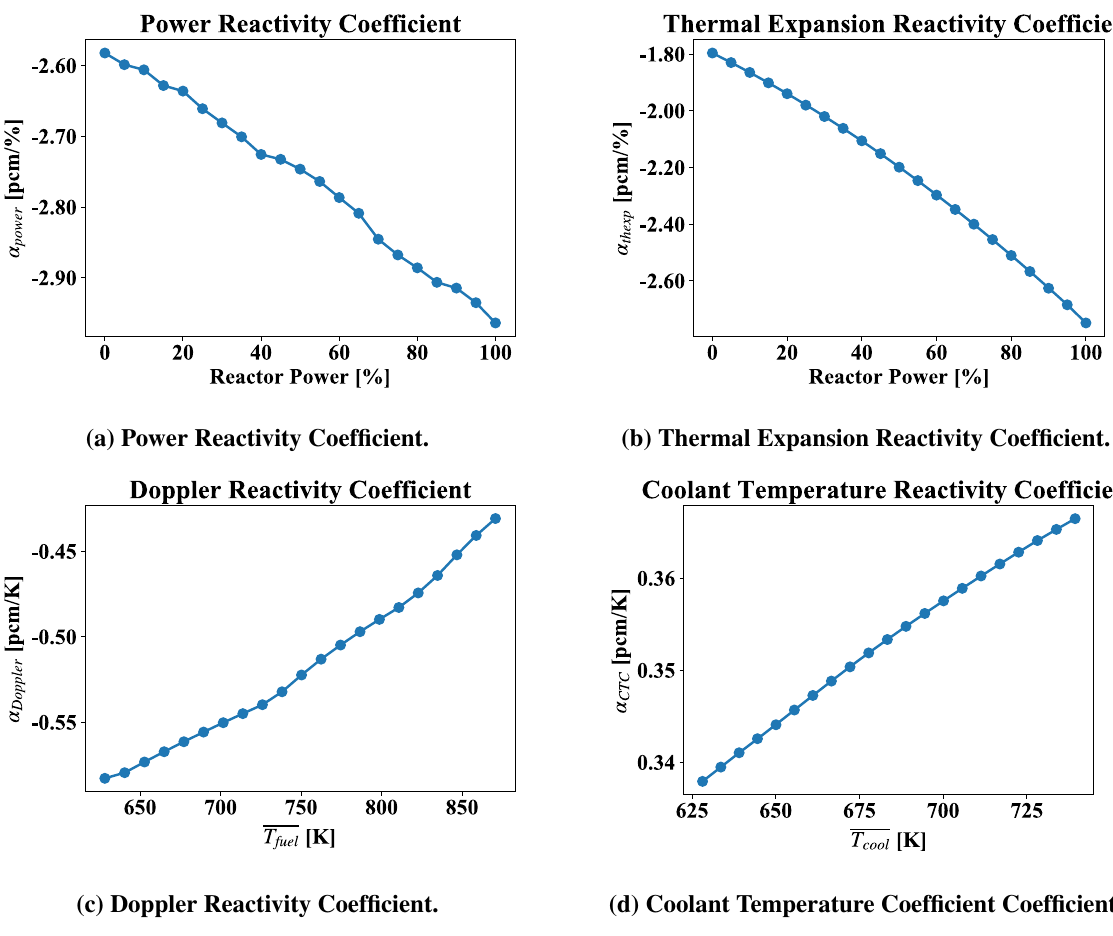
Figure 5: ABR Reactivity